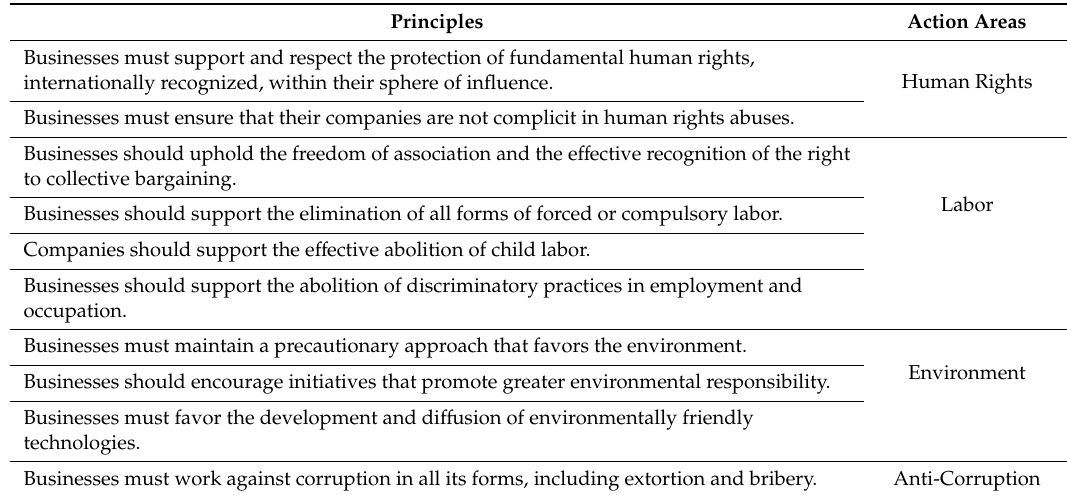
Table 2. UN Global Compact ten